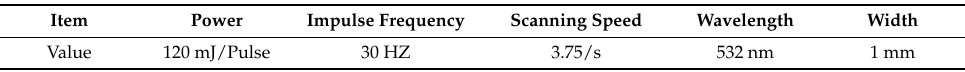
Table 1. The detailed information of the pulsed laser.